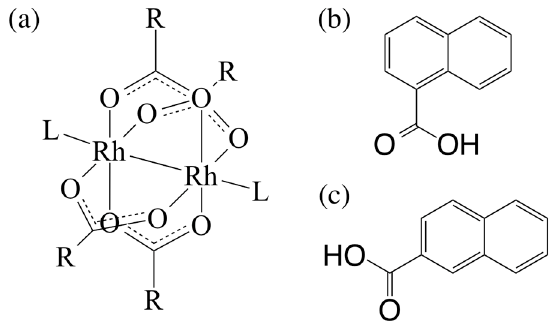
Figure 1. Molecular structures of: ( a ) [Rh 2 (O 2 CR) 4 L 2 ], ( b ) 1-HNC, and ( c ) 2-HNC. Here, R and L moieties in [Rh 2 (O 2 CR) 4 L 2 ] are alkyl (or aromatic) functional groups and axial-coordinated molecules, respectively.